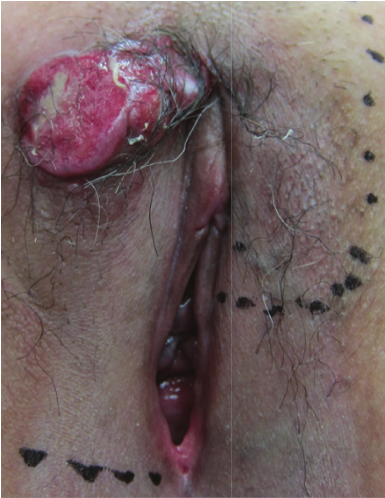
Figure1:Clinicalappearance:a 3.5×3.5 cm,dark-red,hemorrhagic, ulcerated tumor on the right side of the anterior labial